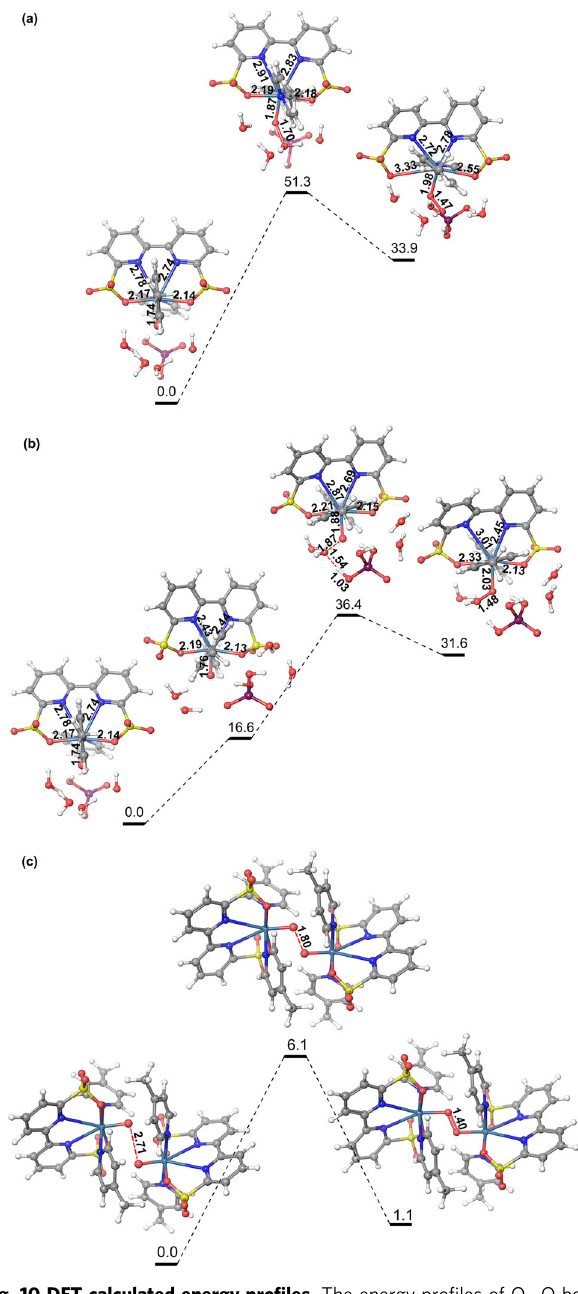
Fig. 10 DFT calculated energy pro fi les. The energy pro fi les of O − O bond formation of Ru IV = O at pH 7.0 with the a WNA of triplet Ru IV = O using H 2 PO 4 − as base, b WNA of singlet Ru IV = O using H 2 PO 4 − as base, and c I2M mechanism. The units of energies are kcal mol − 1 .